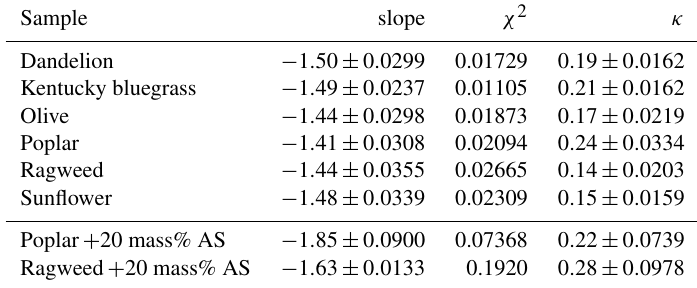
Table 2. Pollenkitt CCN activity: slope of the ln D p , 50 vs. lnSS plot and average hygroscopicity value κ for each particle composition. Sample